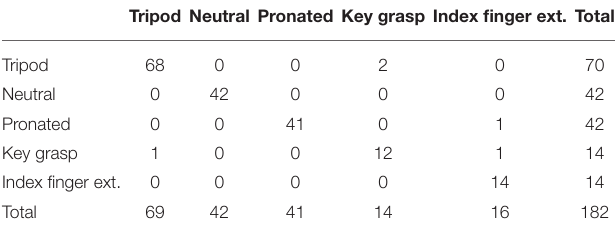
TABLE 5 | Confusion matrix for experiment 3. Tripod Neutral Pronated Key grasp Index finger ext. Total